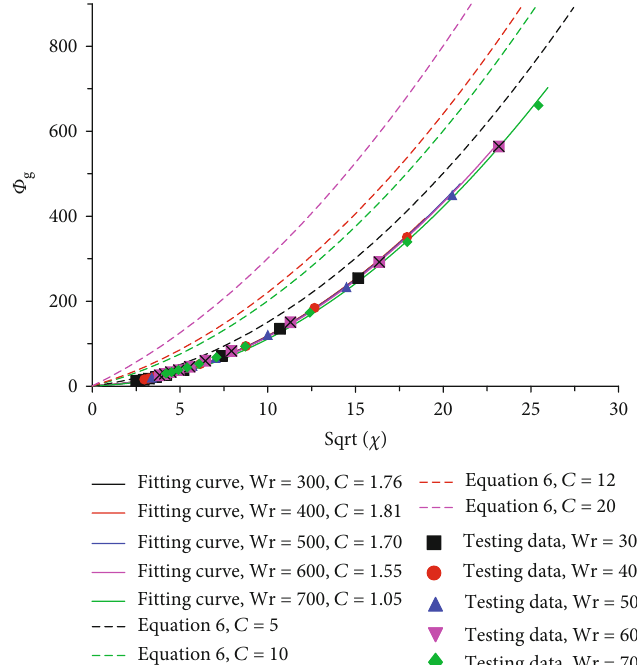
and Sqrt ð χ Þ in case w